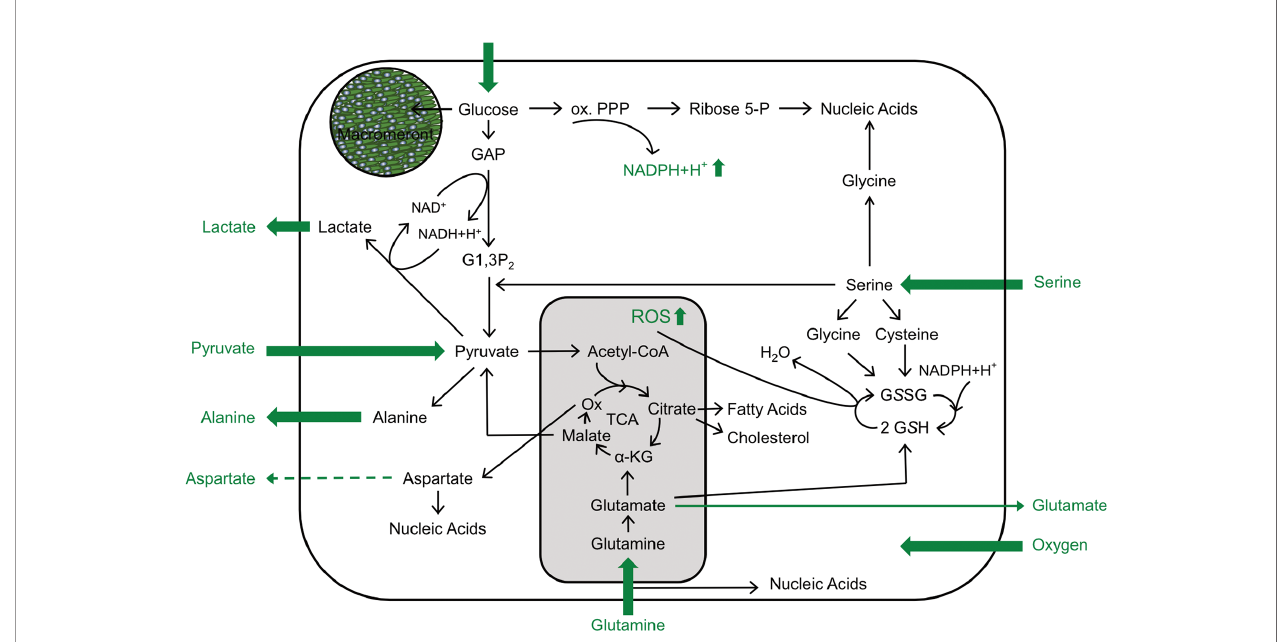
FIGURE 8 | Scheme of E. bovis -driven metabolic modulations of the host cell. Impact of E. bovis on BUVEC metabolism. All metabolic parameters actually measured are shown in green. Thick arrows indicate an increase of the respective metabolic parameter; dashed arrows a decrease, and thin arrows unchanged metabolic